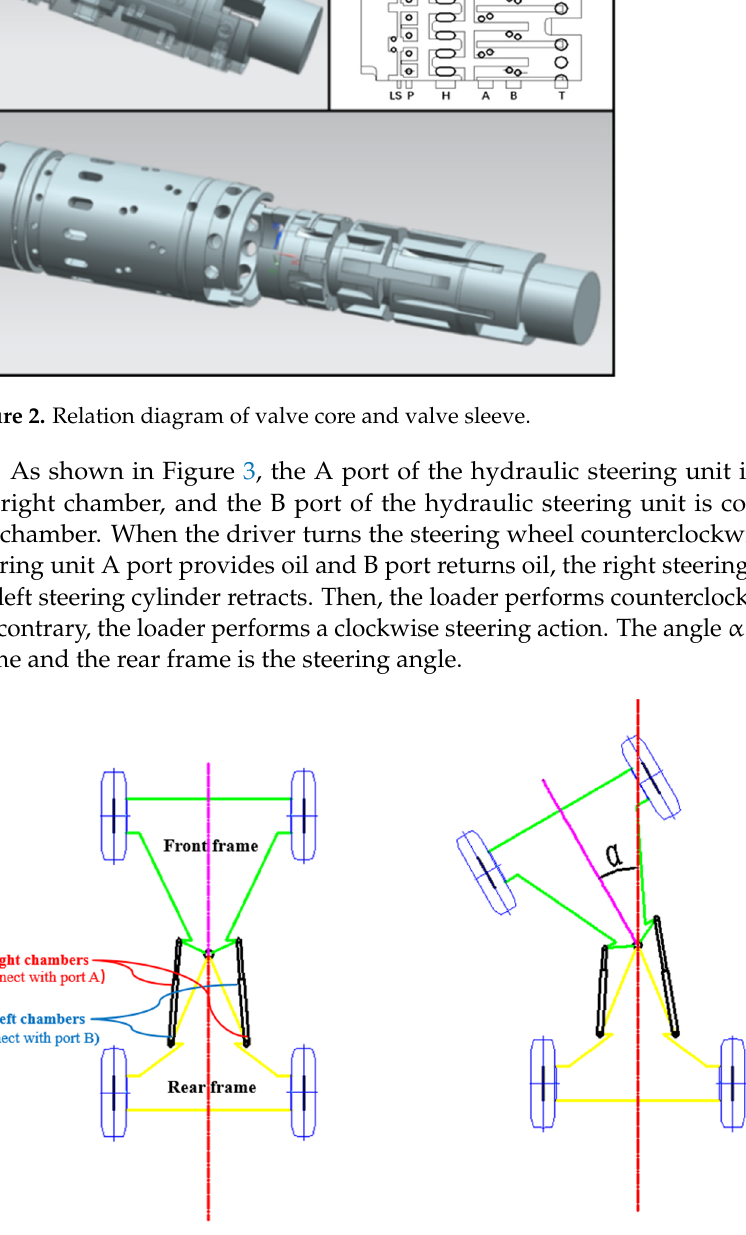
Figure 3. Schematic diagram of the wheel loader steering.